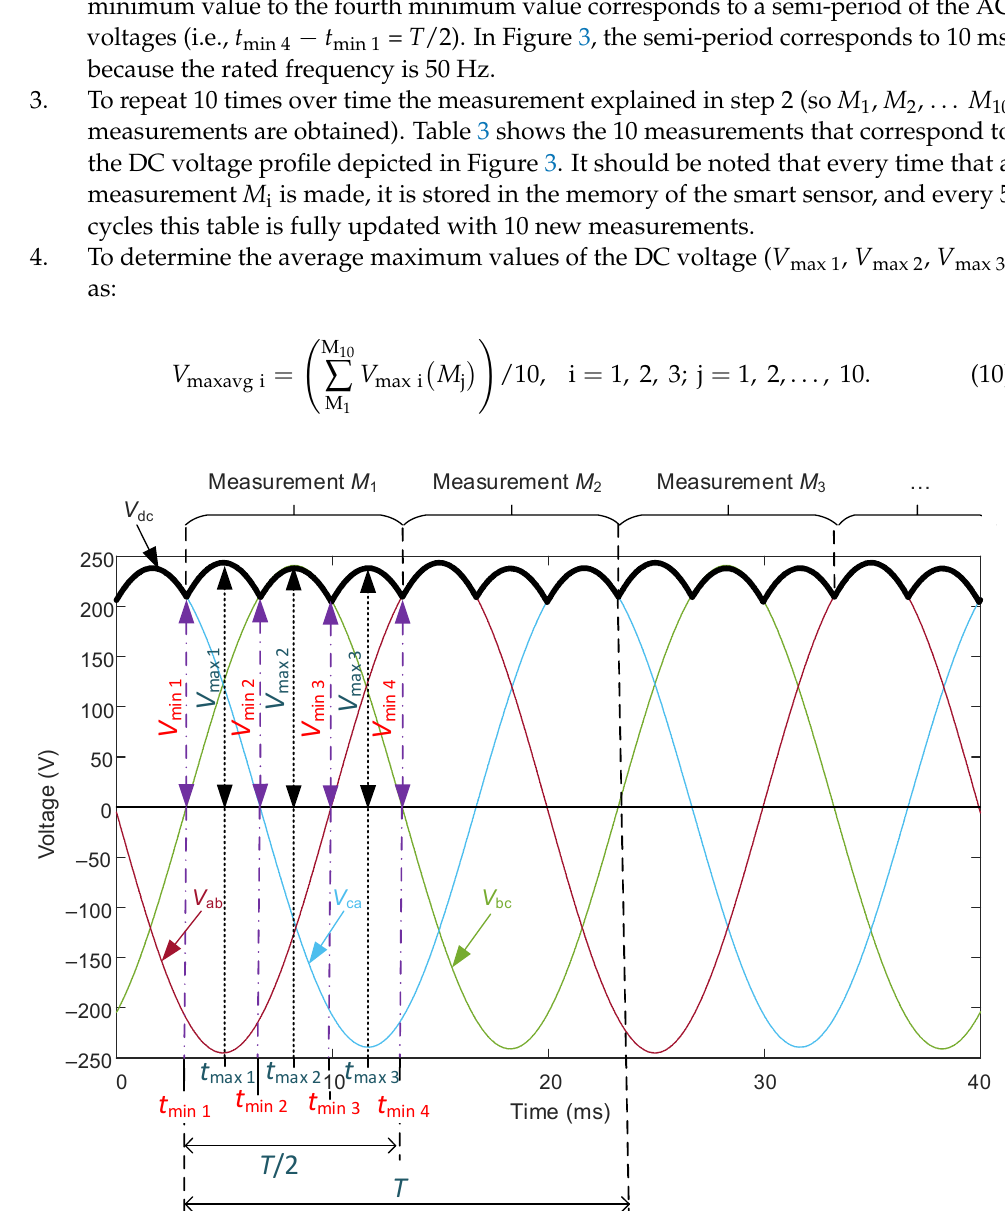
Figure 3. Voltage profile (phase-to-phase voltages and DC voltage) in a three-phase diode bridge rectifier with the following unbalanced voltage supply: phase-a voltage drop of 5% with respect to its rated value (100 V, 50 Hz). Determination of its first 3 consecutive maximum values and its first 4 consecutive maximum values, with their corresponding time values. Table 3. Ten measurements of 3 consecutive maximum values of the DC voltage and 4 consecutive time values in which the DC voltage has its minimum values. The values correspond to the DC voltage profile shown in Figure 3.